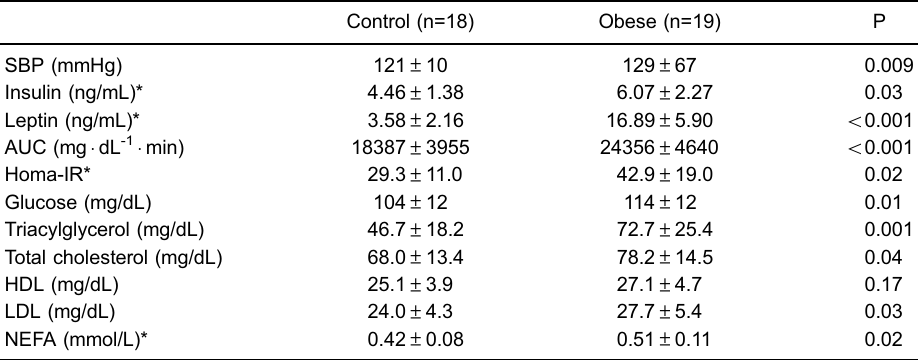
Table 2. Obesity - related